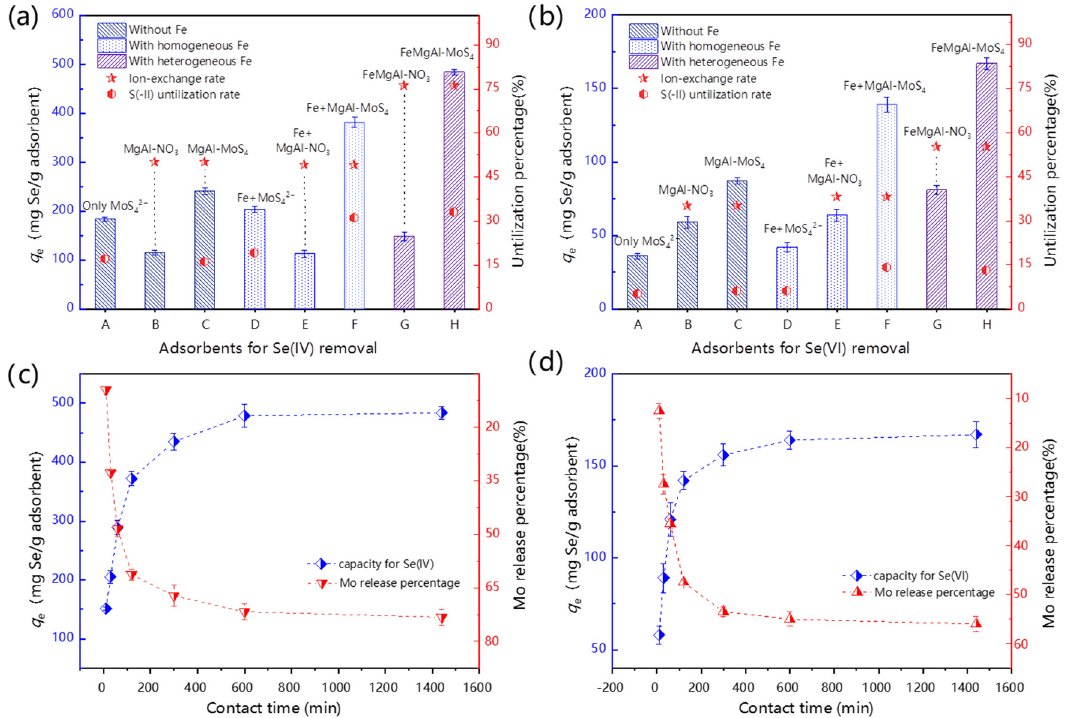
Figure 2. Capacities and utilization percent comparison of different adsorbents or their combina- tions for Se(IV) ( a ), and Se(VI) ( b ) removal (Phase ratio = 1.0 g/L, contact time = 24 h, 25 °C, C 0 (Se) = 1000 mg/L, without adjustment of pHs); sorption kinetics and release of Mo ions when Se(IV) ( c ), and Se(VI) ( d ) on FeMgAl − MoS 4 (Phase ratio = 1.0 g/L, 25 °C, C 0 (Se) = 1000 mg/L for Se(IV) and 600 mg/L for Se(VI), without adjustment of pHs, at different time intervals).